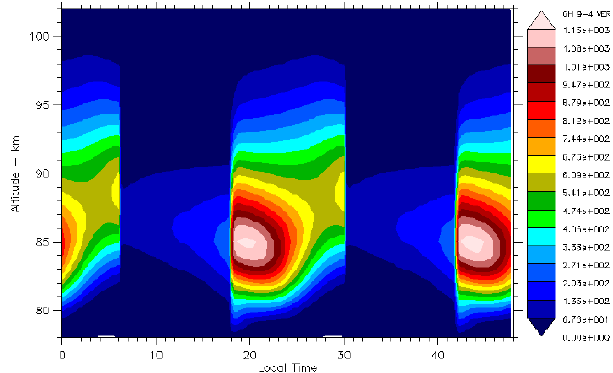
Fig. 7a. Model OH ∗ 9-4 volume emission rates for April, days seven through eight, from model [O 3 ] and (H) values. Rates are from Adler-Golden (1997). VER units are in photons cm − 3 s − 1 .